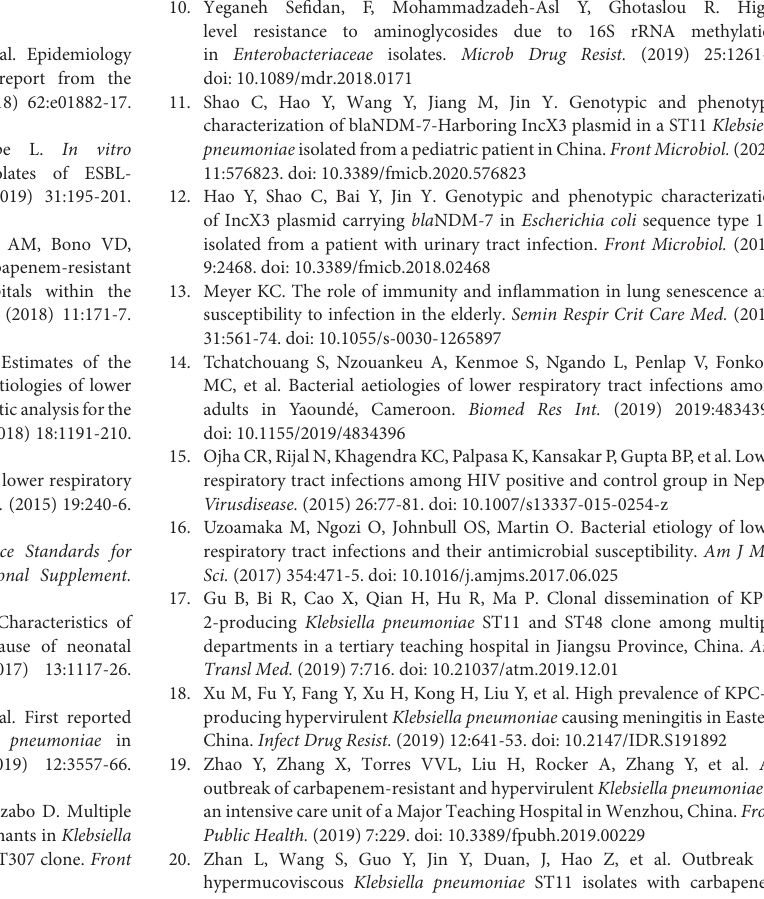
Supplementary Figure 1 | S1-PFGE results for 31 CRKp isolates. Supplementary Table 1 | Primers used in the present